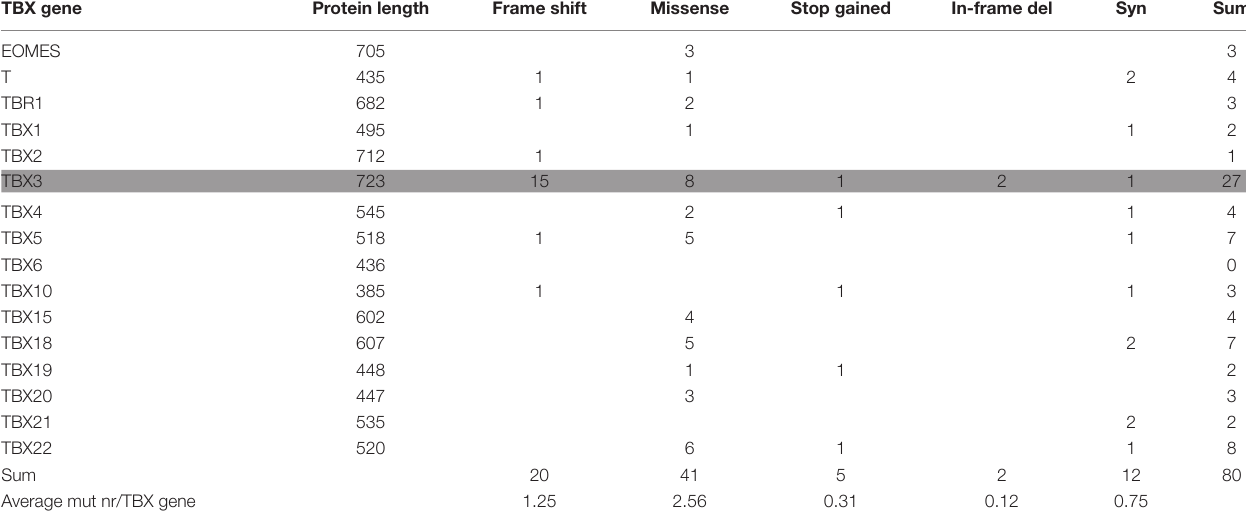
The TCGA breast cancer data set was analyzed for five types of mutations affecting the open reading frame (ORF) of TBX genes. ORF length is in the second column. In the second but last column, synonymous codon changes (syn) are listed. The row at the bottom presents the mutation number averaged over 16 TBX genes. This allows to calculate the enrichment of particular mutation types in TBX3